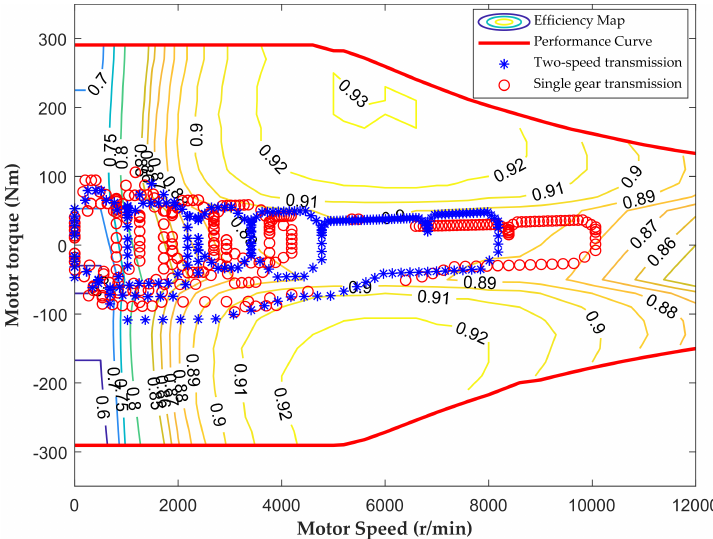
Figure 7. The motor operating points in NEDC drive